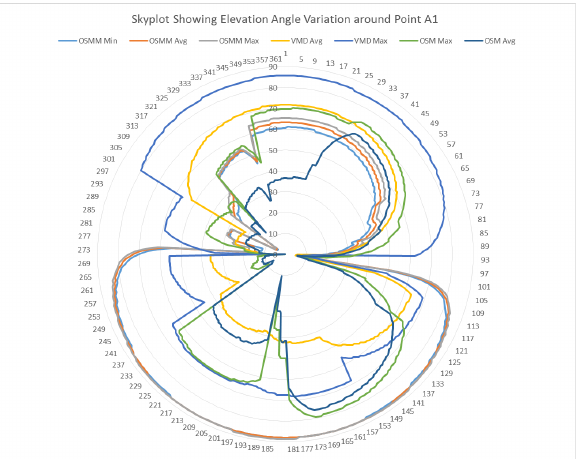
Figure 9: Skyplot showing the variation in elevation values around a single point (Point A1, Figure 10)